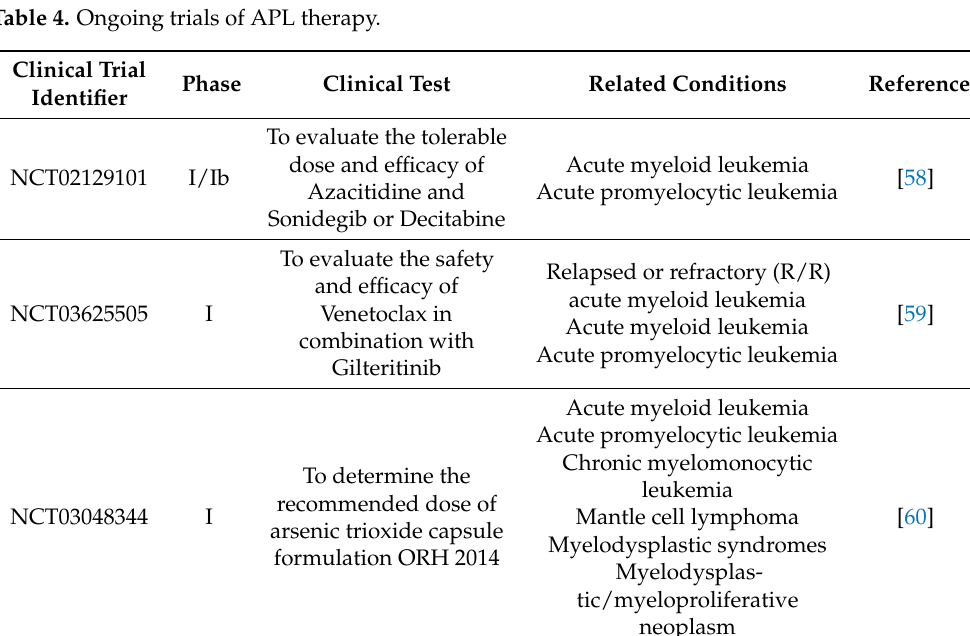
Table 4. Ongoing trials of APL